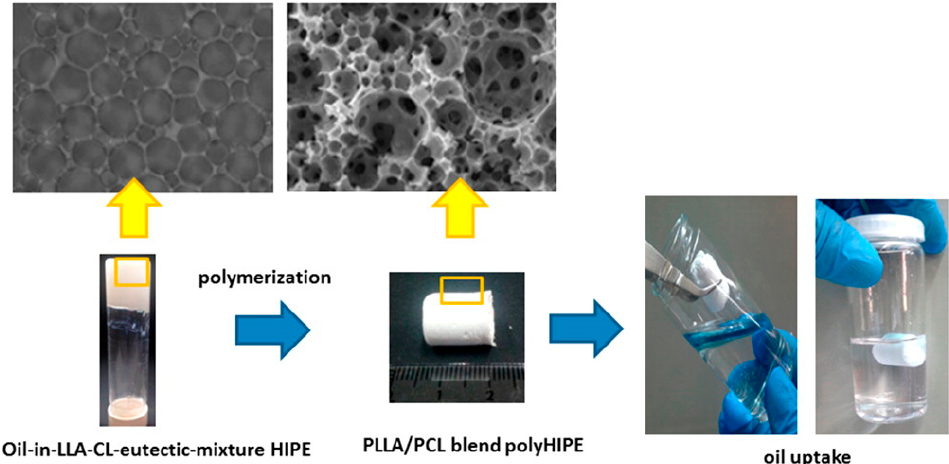
Figure 9. Oil-in-Eutectic polymerized high internal phase emulsions (polyHIPEs) prepared via the emulsification of tetradecane with a 30:70 mol/mol mixture of L -lactide (L-LA) and ε -caprolactone (CL) and subsequent ring opening polymerization of the continuous phase. The resulting polyHIPEs were subsequently used as absorbent materials for hydrocarbon uptake. Reproduced with permission from [83], Copyright 2016, American Chemical Society.